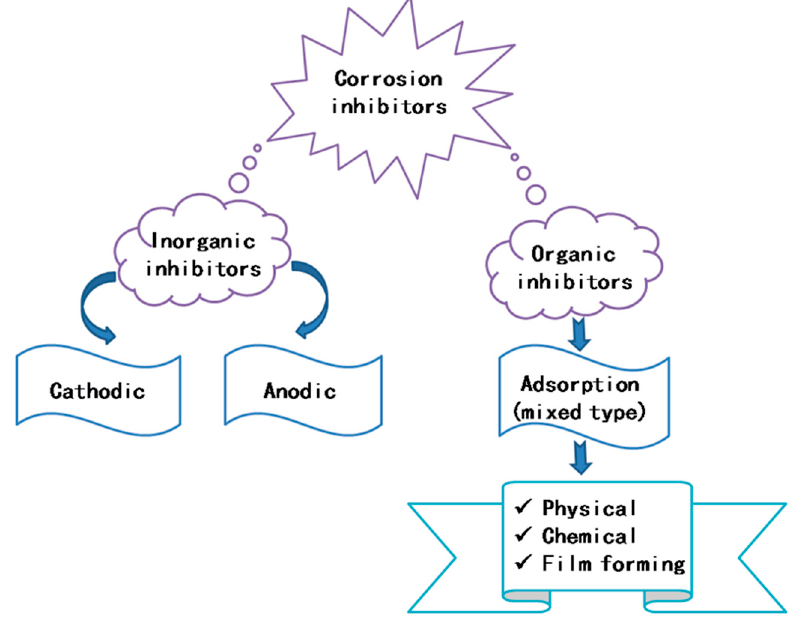
Figure 8. Classification of organic and inorganic corrosion inhibitors.